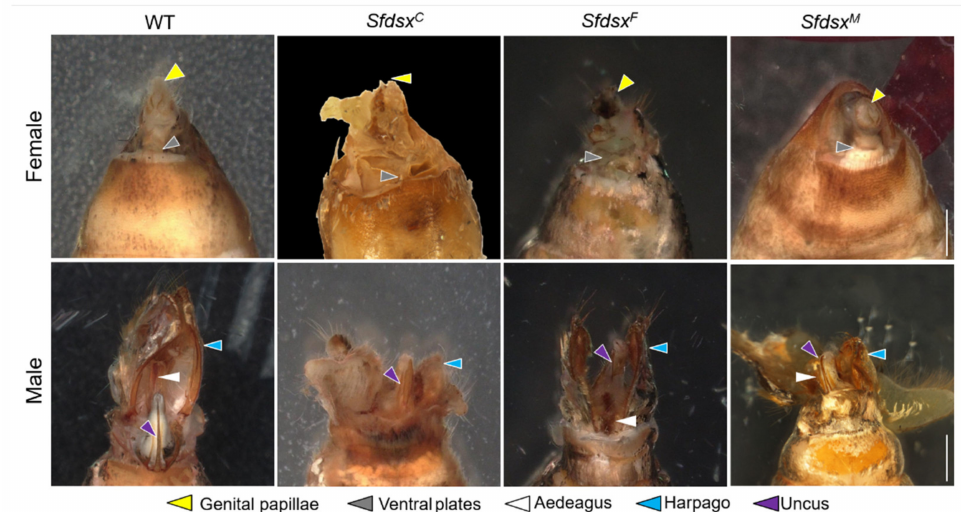
Figure 3. Deformation of external genitalia in Sfdsx C , Sfdsx F , and Sfdsx M mutants at adult stage. The WT male-specific adult external structure consists of a pair of harpago, an aedeagus, and an uncus, whereas the female-specific external genitals include genital papillae and a ventral plate. Compared with WT, the external genitalia of Sfdsx C , Sfdsx F , and Sfdsx M mutants were abnormal. Different color of triangles represents sex-specific external genital structures. Scale bars: 1 mm.